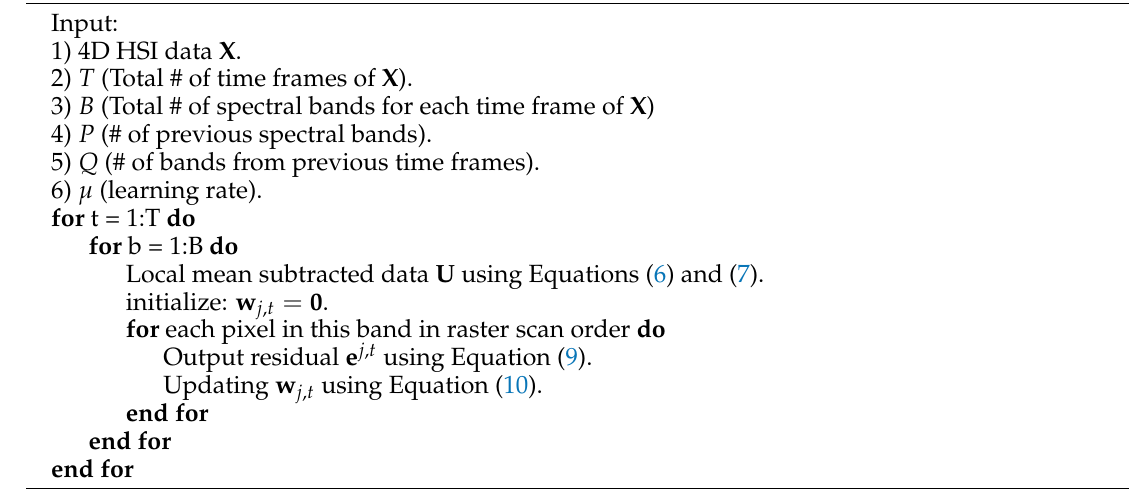
Algorithm 1 Fast-Lossless-4D